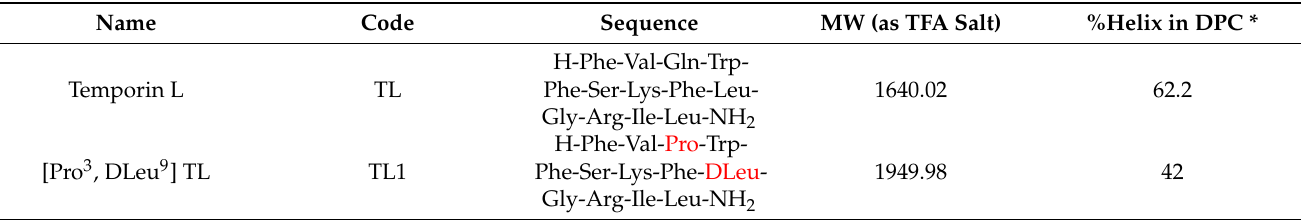
Table 1. TL and [Pro 3 , DLeu 9 ] TL. Names, codes, sequences, and some properties (molecular weight and helical percentage) of TL and [Pro 3 , DLeu 9 ] TL